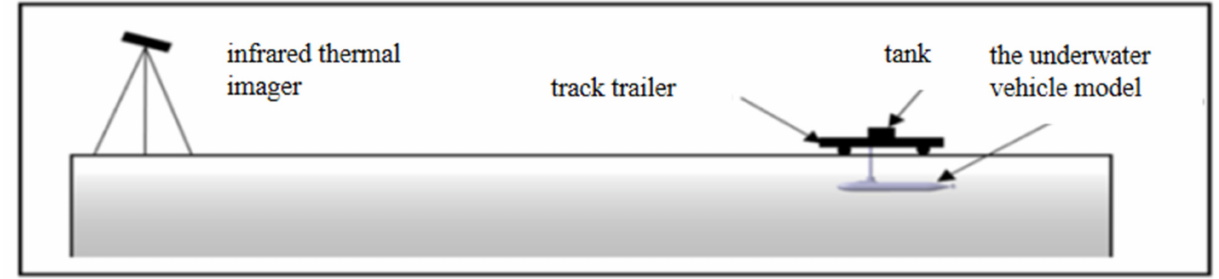
Figure 11. Experimental